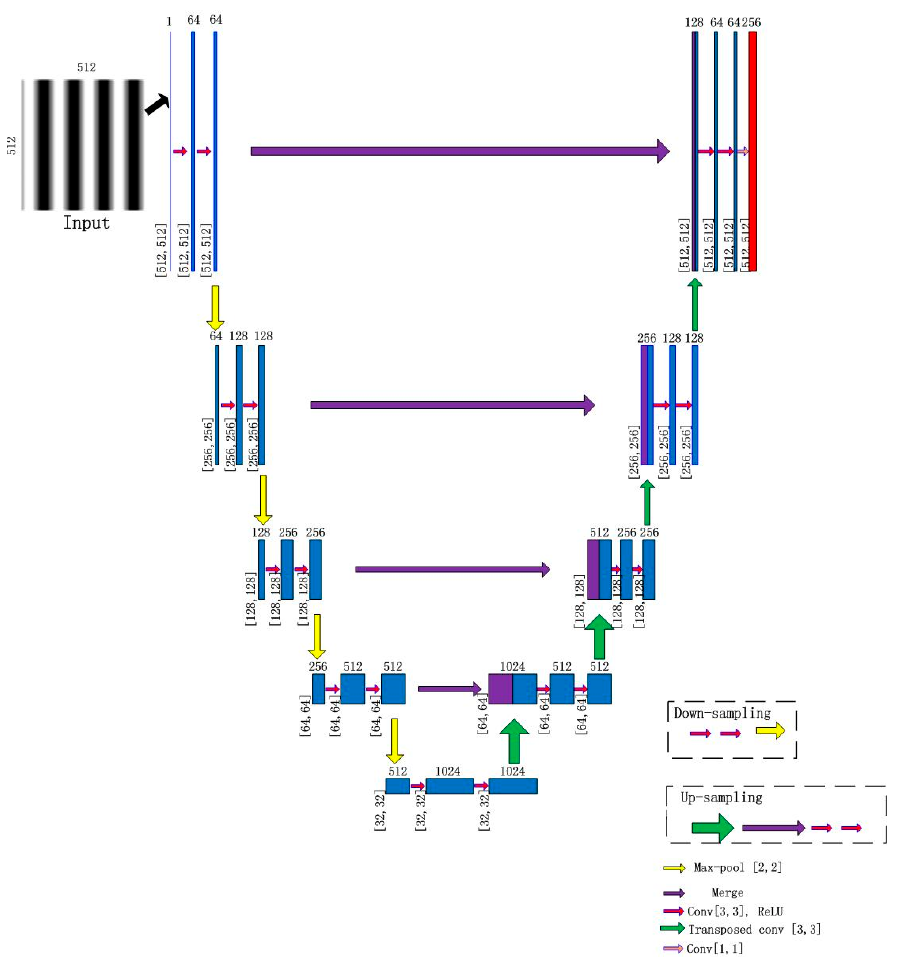
Figure 3. Process of network propagation.